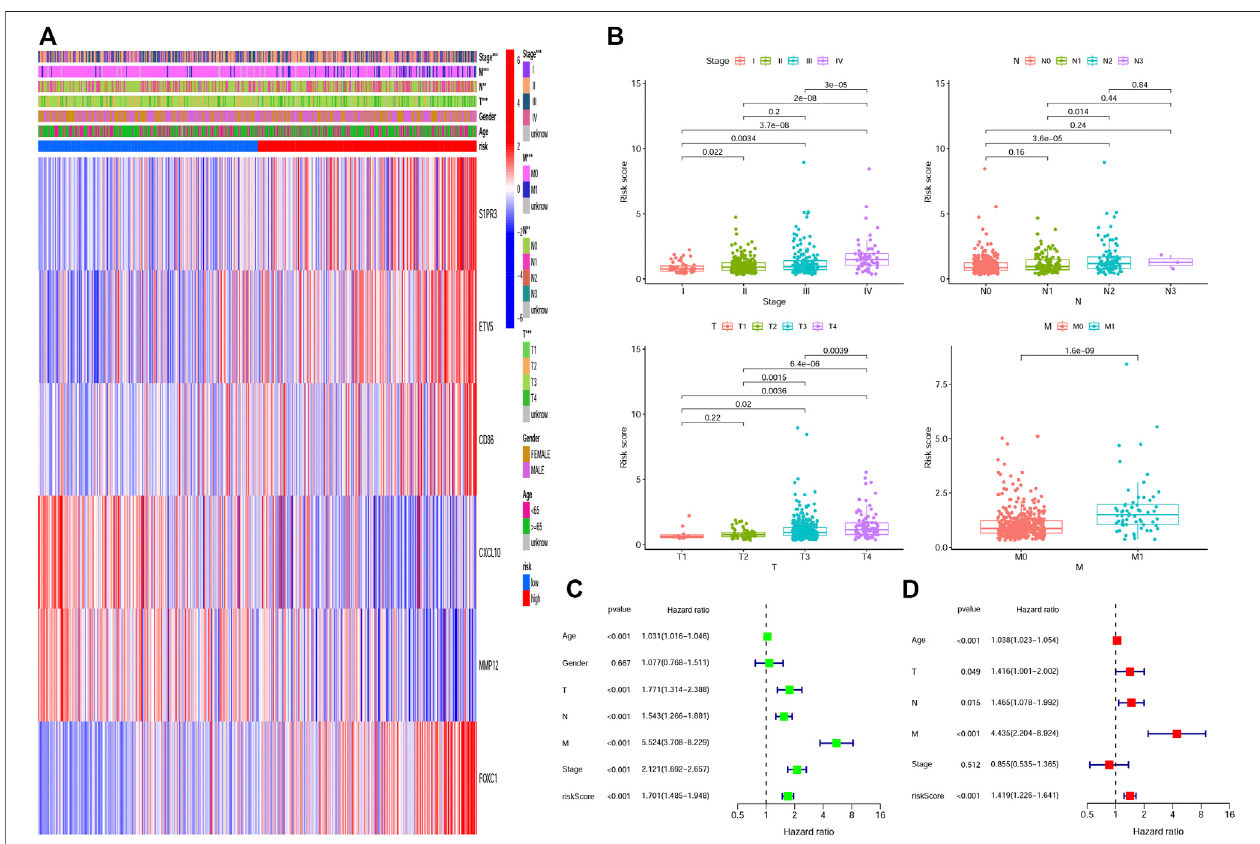
FIGURE 5 | Correlation and independent prognosis analysis of HRG-score and clinical parameters in the training set. (A,B) Univariate and multivariate analyses of the prognostic value of the HRG-score. (C) Relationships between clinical parameters and the low- and high-risk groups. (D) Clinical application value of HRG-score in predicting T stage, N stage, M stage, and TNM stage, respectively (* p < 0.05; ** p < 0.01; *** p <